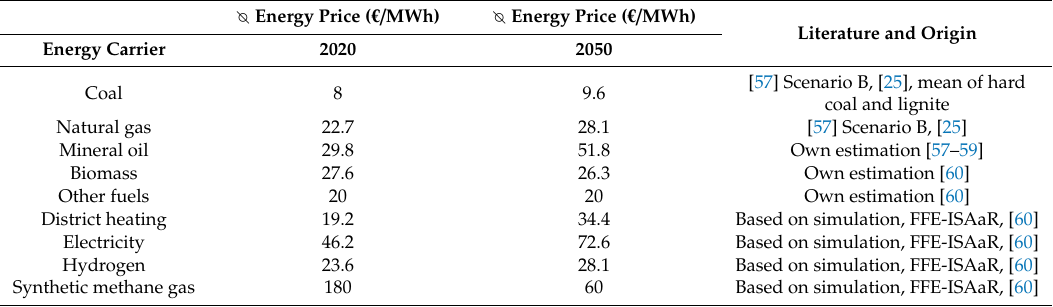
Table A2. Energy prices used in the technology mix scenario.